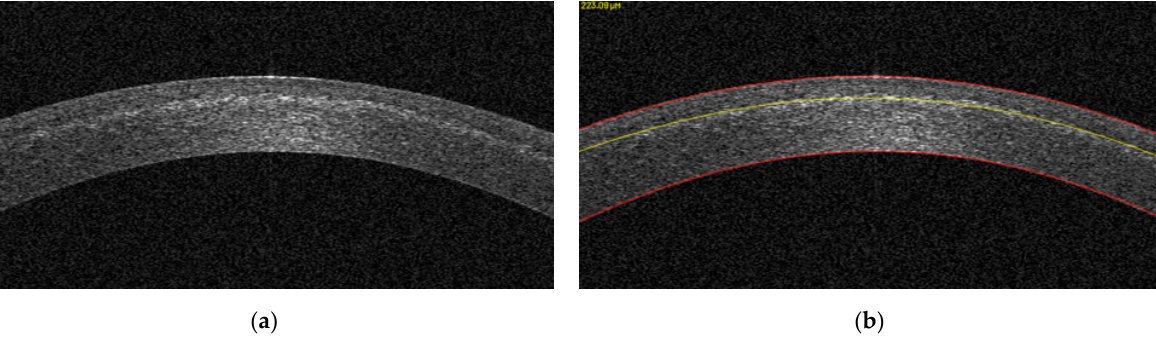
Figure 1. OCT image, cropped by the OCT Analysis software, at the center of the cornea ( a ), and the same OCT image after image processing ( b ). The red lines constitute the upper and lower corneal boundaries, while the yellow line represents the detected demarcation line with its depth in micrometers displayed on the top left of the image.